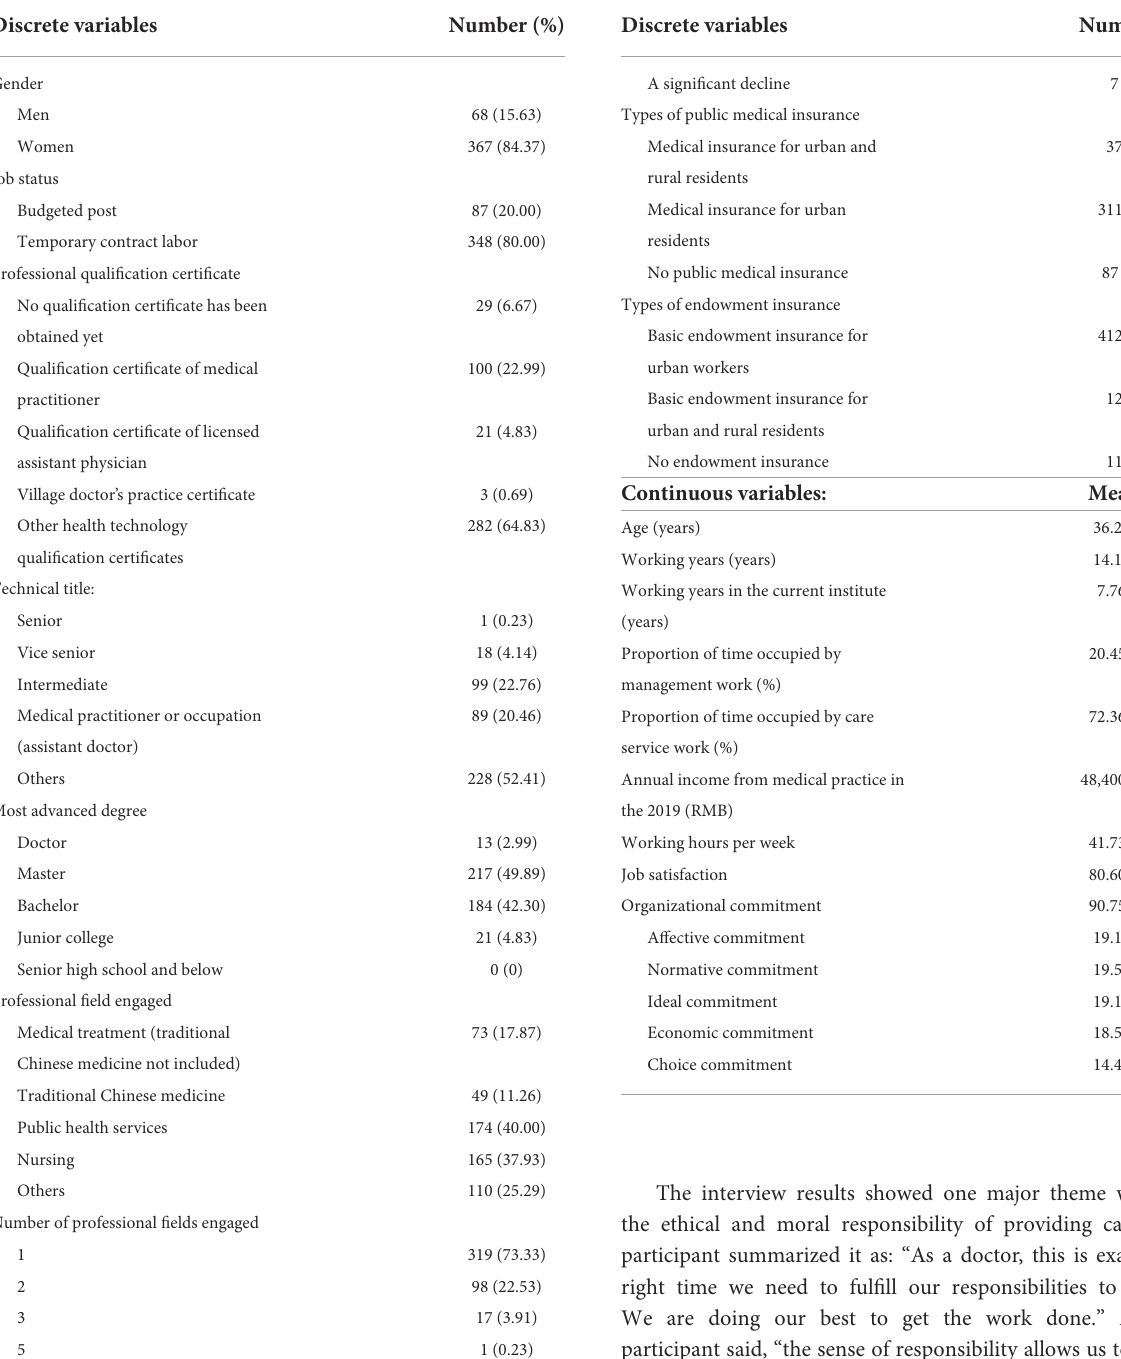
TABLE 1 Characteristics of included participants ( N =